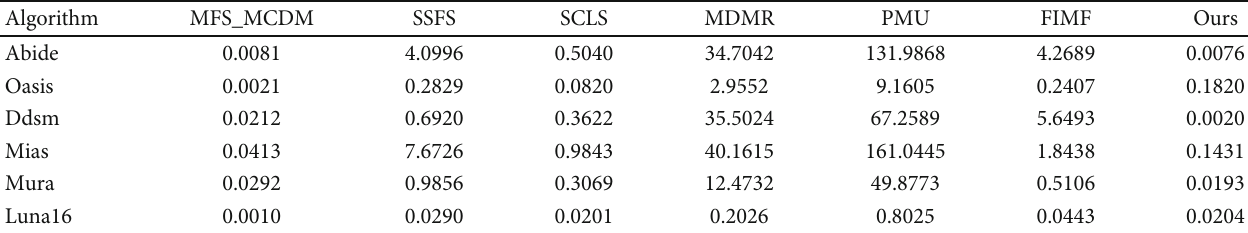
Table 8: Running time (sec) of the multilabel feature selection